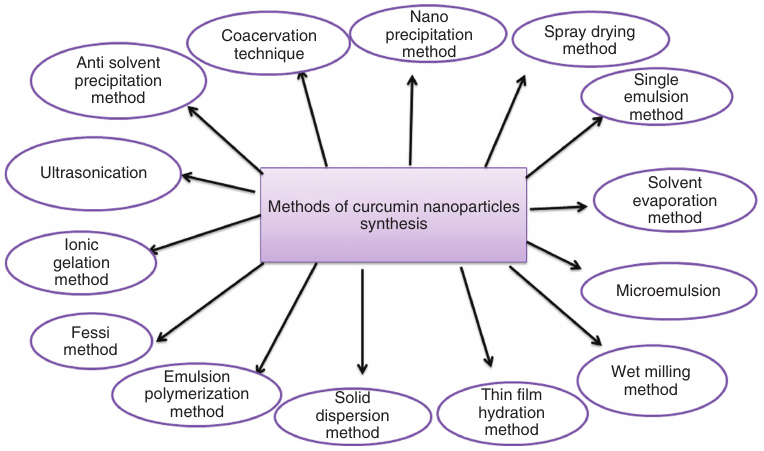
Figure 4: Methods of synthesis of curcumin